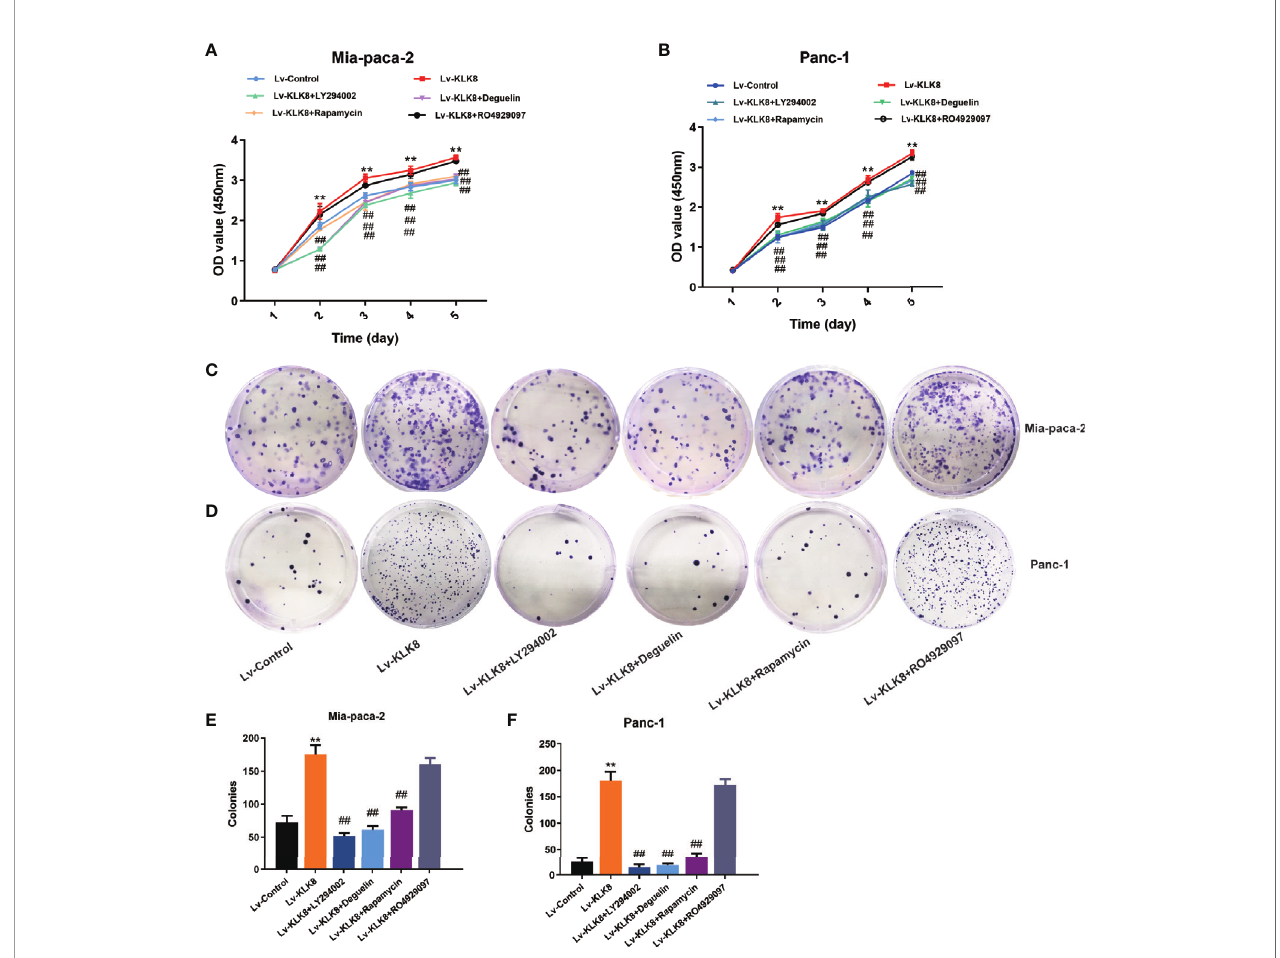
FIGURE 6 | KLK8 promoted pancreatic cancer cells proliferation via the activation of the PI3K-Akt-mTOR pathway. Mia-paca-2 and Panc-1 cells in Lv-KLK8 group were treated with PI3K inhibitor LY294002(75 m M), Akt inhibitor Deguelin (500 nM), mTOR inhibitor Rapamycin (100 nM) or Notch inhibitor RO4929097 (10 m M) in Mia-paca-2 and Panc-1 cells. (A, B) Cell proliferation was detected by CCK8 Assay in Mia-paca-2 (A) and Panc-1 (B) cells. (C, D) Colony formation was detected in Mia-paca-2 (C) and Panc-1 (D) cells. (E, F) demonstrated the quanti fi ed data of cell colonies. Data were presented as the mean ± SEM (n=3). **p < 0.01 vs Lv- control; p < 0.05, ## p < 0.01 vs